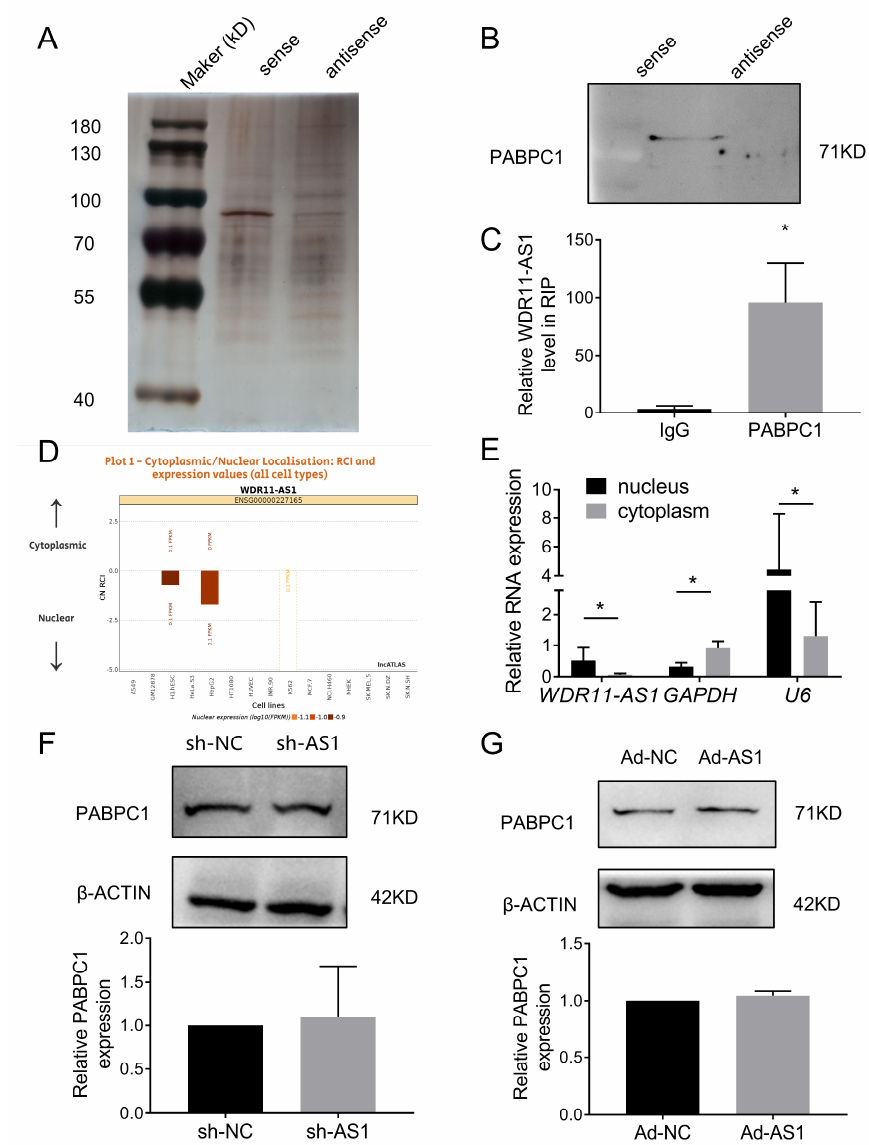
Figure 4. lncRNA WDR11-AS1 binds to PABPC1, but does not alter PABPC1 expression, in chon- drocytes. ( A ) Silver-stained gel of WDR11-AS1 interacting proteins isolated from SW1353 cells subjected to RNA pulldown assay using sense or antisense of WDR11-AS1. ( B ) Western blot analysis showed the binding of WDR11-AS1 to PABPC1 from RNA pulldown assay. ( C ) RT-qPCR from RIP analysis showed WDR11-AS1 in PABPC1 immunoprecipitates and IgG (control) from SW1353 lysates. ( D ) Prediction of subcellular localization of lncRNA WDR11-AS1 on the lncATLAS website. ( E ) Detection of subcellular localization of lncRNA WDR11-AS1 in primary chondrocytes by fraction- ation of nuclear and cytoplasmic RNA analysis. ( F , G ) Western blot analysis showed PABPC1 protein levels after WDR11-AS1 knockdown ( F ) or overexpression ( G ) in primary chondrocytes. * p < 0.05, PABPC1 vs. IgG ( C ); for ( C , E – G ), the measurement data are expressed as the mean ± standard deviation, and were analyzed by Mann–Whitney U test. The experiments were repeated three times. Studies report that lncRNAs can interact with PABPC1 and regulate PABPC1 protein expression [18,21]. Given the interaction between WDR11-AS1 and PABPC1, we speculated whether WDR11-AS1 regulates PABPC1 protein expression. Then, we predicted the subcellu- lar localization of WDR11-AS1 using the lncATLAS website (http://lncatlas.crg.eu/ (accessed on 24 May 2020)). We found that lncRNA WDR11-AS1 was predominantly localized to